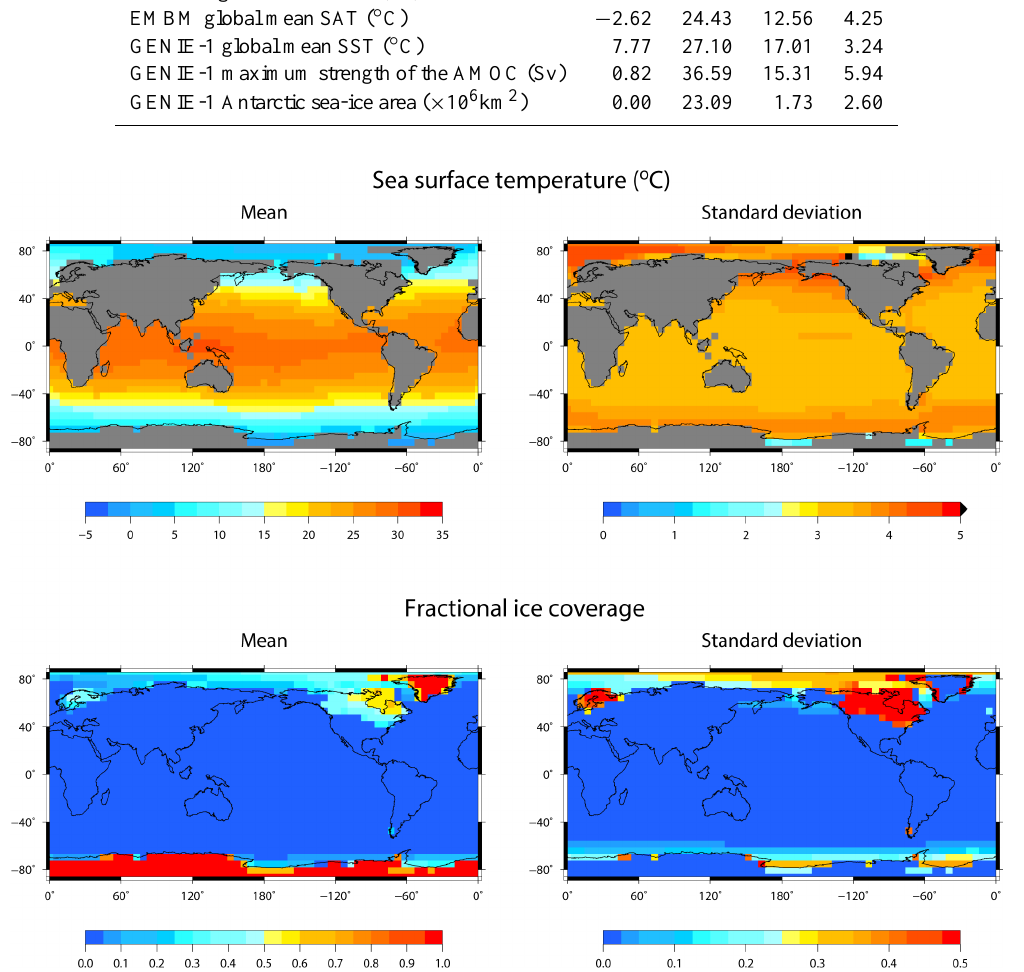
Figure 1. The mean and standard deviation of SST and fractional ice coverage across the 600-member ensemble. The SST and sea-ice coverage are prognostic output of GENIE-1 while the land ice coverage is regridded from Peltier ICE-5G. These fields, among others, are applied as surface boundary conditions to drive PLASIM